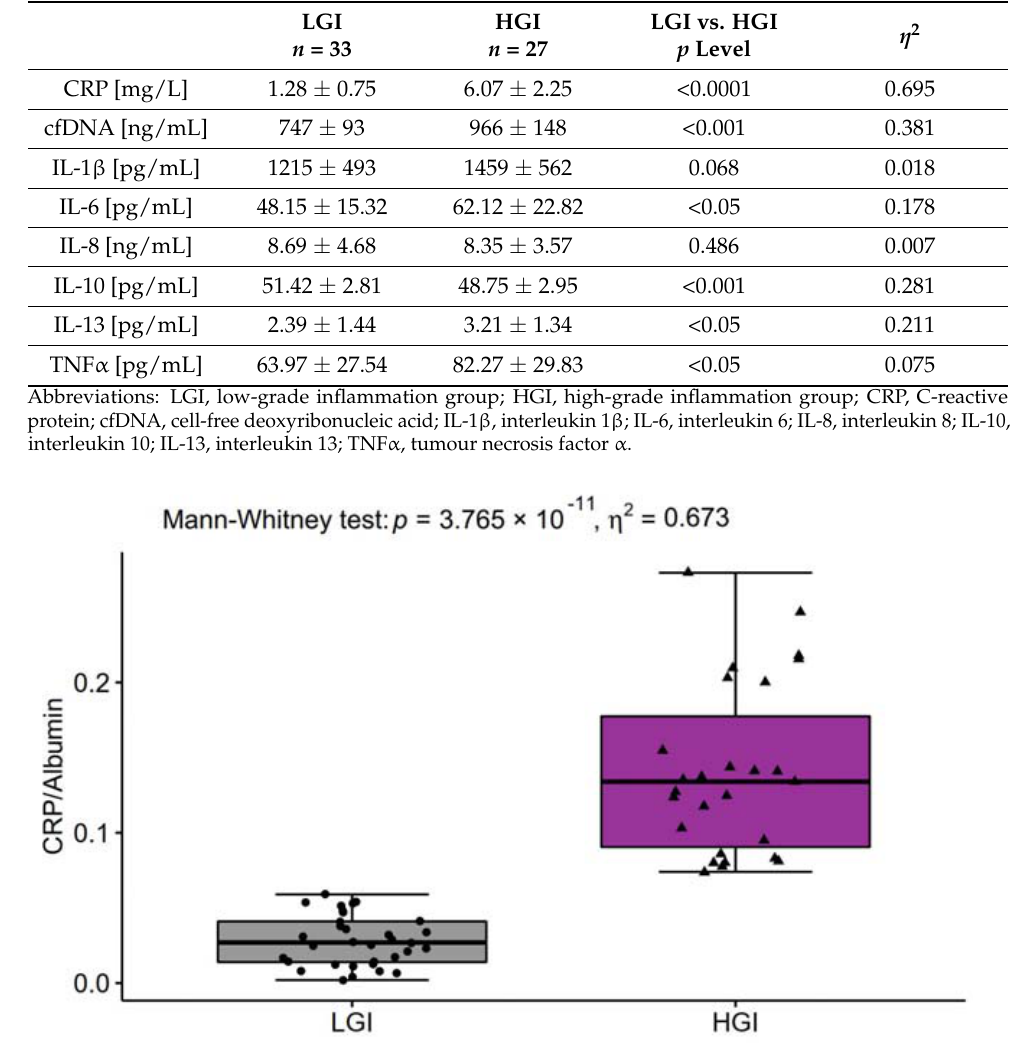
Table 6. Inflammatory variables (mean ± SD).